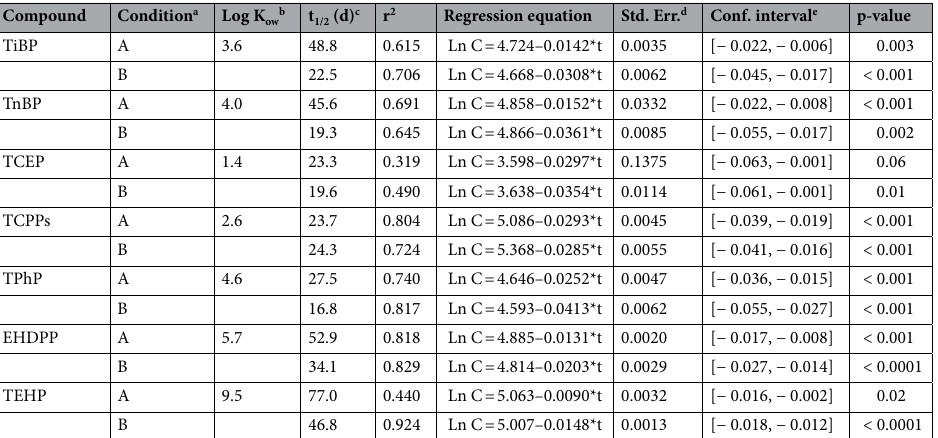
Table 1. Estimated half-lives (t ½ , days) for the target OPEs in the sediment with regression parameters (n = 12). p-value < 0.05 significant. a A = Abiotic; B = Biotic; b log K ow estimated by EPIWEB 4.1; c Half-live (days); d Standard error of the slope; e 95% Confidence interval of the